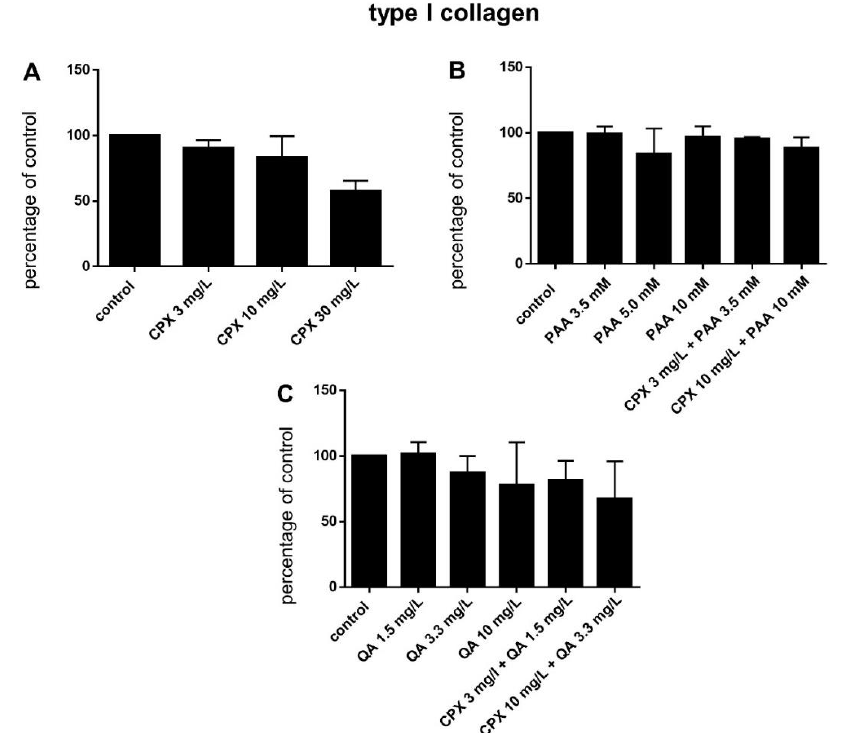
Figure 7. Tenocyte type I collagen expression after 72 h in response to stimulation with CPX alone and with PAA and QA, alone and in combination with CPX. ( A ) CPX, ( B ) PAA combined with CPX , ( C ) QA combined with CPX. Fluorescence intensities were analyzed using ImageJ. Bars show the mean ± SD.